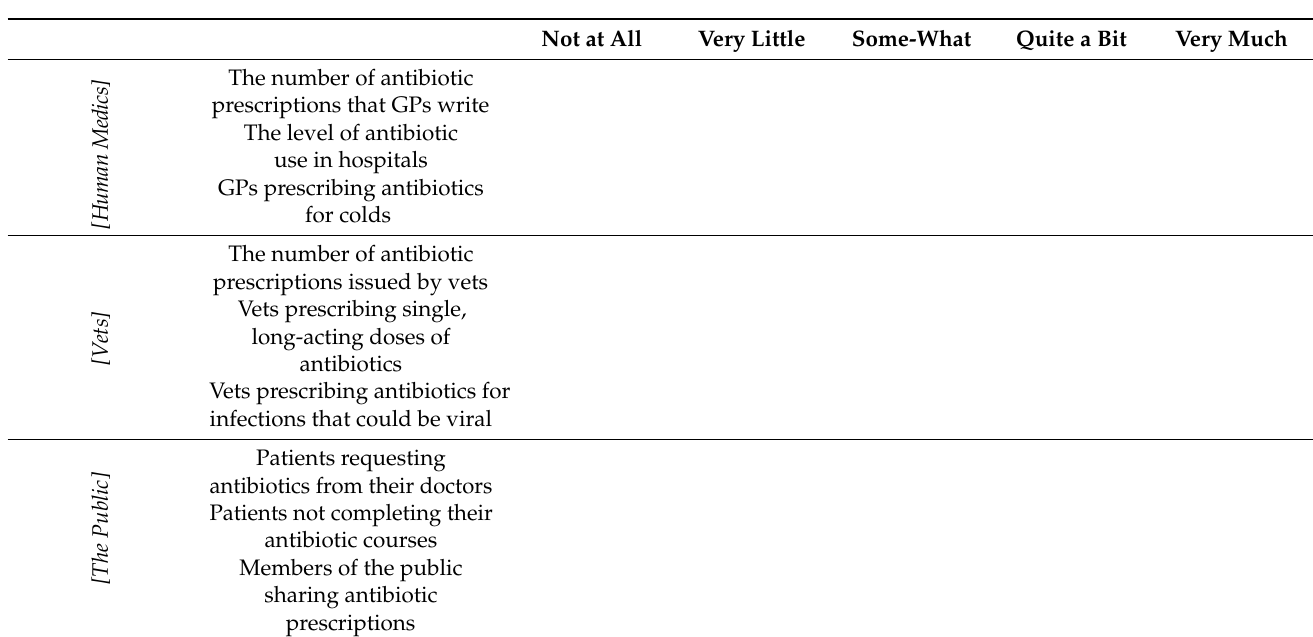
Table A3. Responsibility for causing ABR